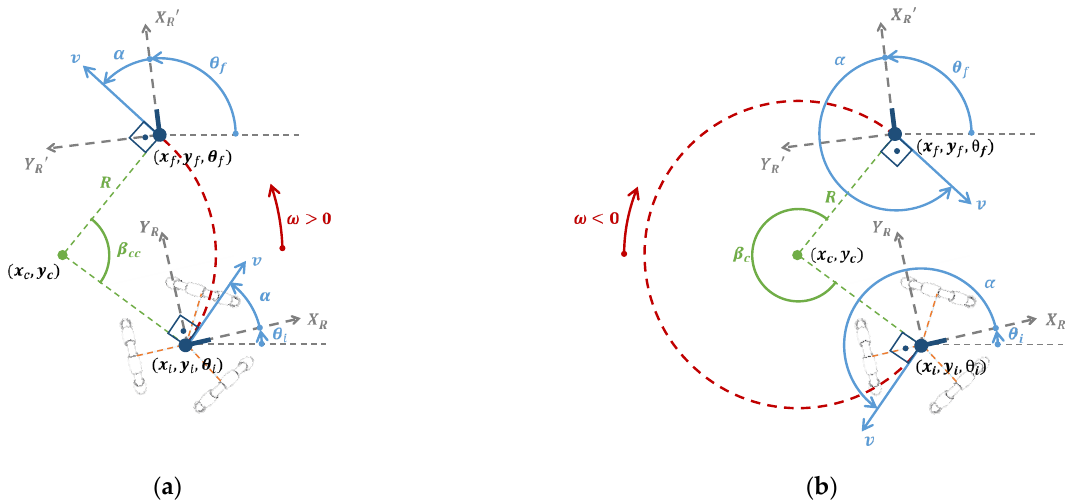
Figure 4. Simulation of the trajectories generated by motion commands 𝑀 = (𝑣,𝛼, 𝜔, 𝑡 𝑟 = 10𝑠) . The starting point is (𝑥 = 0, 𝑦 = 0, 𝜃 = 0) , and the velocity 𝑣 = 0.3 m/s. Showing 8 different angular orientations 𝛼 : 0° (red), 45° (green), 90° (blue), 135° (cyan), 180° (black), 225° (yellow), 270° (magenta), 315° (olive), and different angular rotational speeds: ( a ) 𝜔 = 0.0 rad/s, ( b ) 𝜔 = 1.0 rad/s, ( c ) 𝜔 = 1.5 rad/s, ( d ) 𝜔 = 2.0 rad/s, ( e ) 𝜔 = − 1.0 rad/s, ( f ) 𝜔 = − 1.5 rad/s, ( g ) 𝜔 = − 2.0 rad/s.